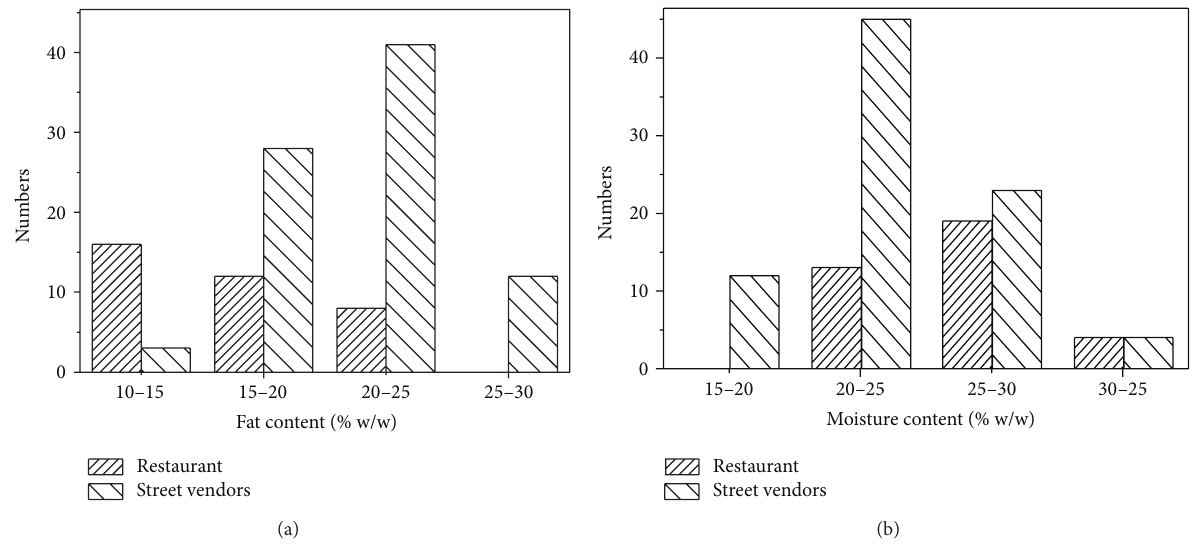
Figure 1: The distribution of (a) fat and (b) moisture content in FBS collected from fast-food restaurants and street vendors.